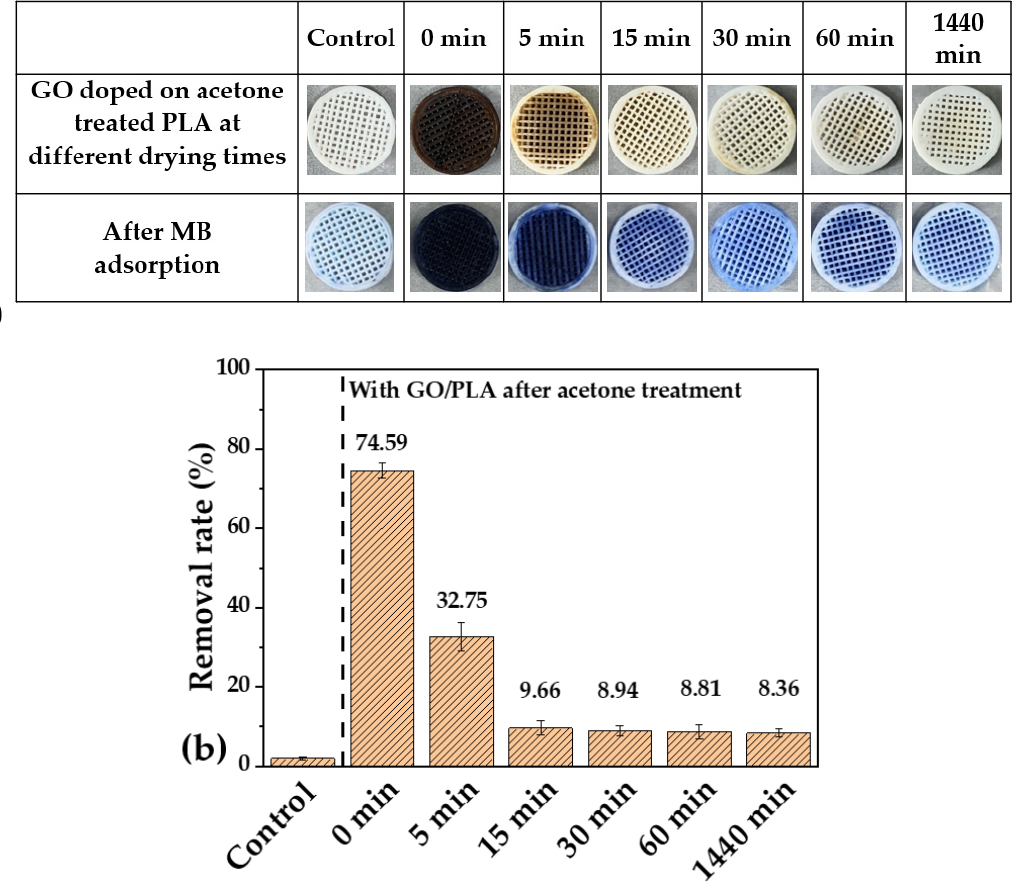
Figure 3. ( a ) Changes in the degree of GO doping with drying time after acetone treatment and ( b ) MB removal rate of GO/PLA filters with different drying time after acetone treatment. The experimental conditions were as follows: [MB] 0 = 50 mg/L, reaction time = 24 h, weight of added PLA and GO/PLA filters = 0.2 g, and initial pH = 6.5.